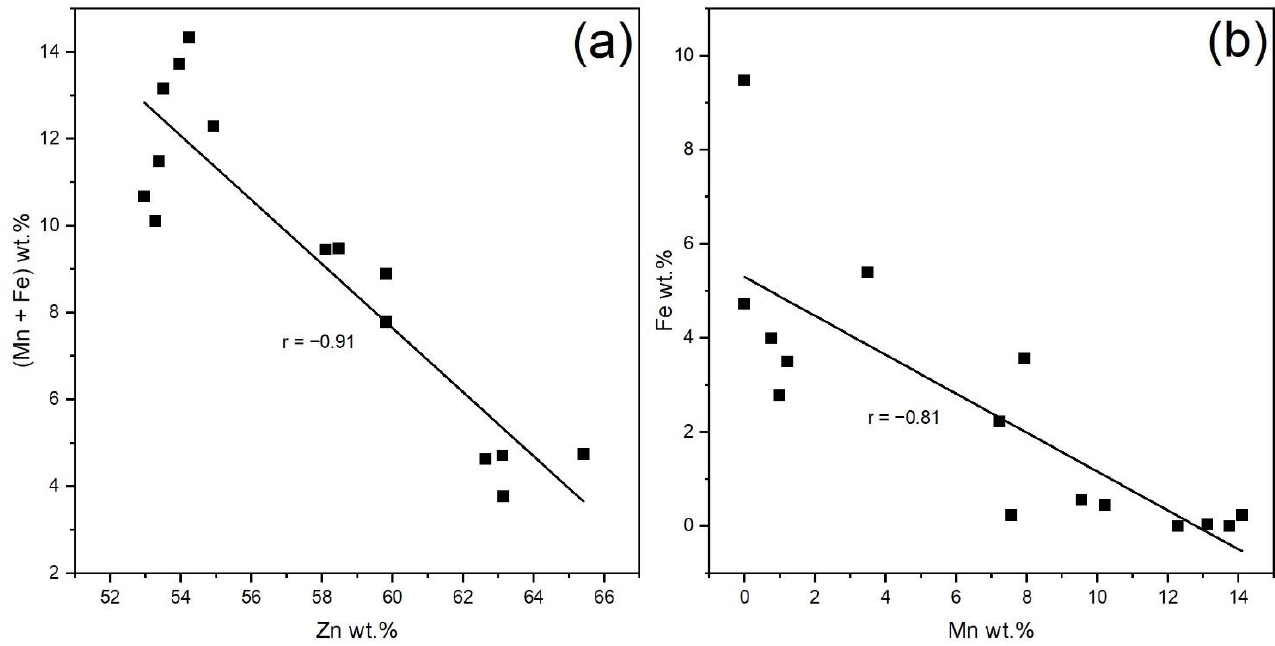
Figure 7. ( a ) Correlation between Zn and Mn + Fe (wt.%); ( b ) correlation between Mn and Fe (wt.%) in sphalerites from the Săcărâmb ore deposit.